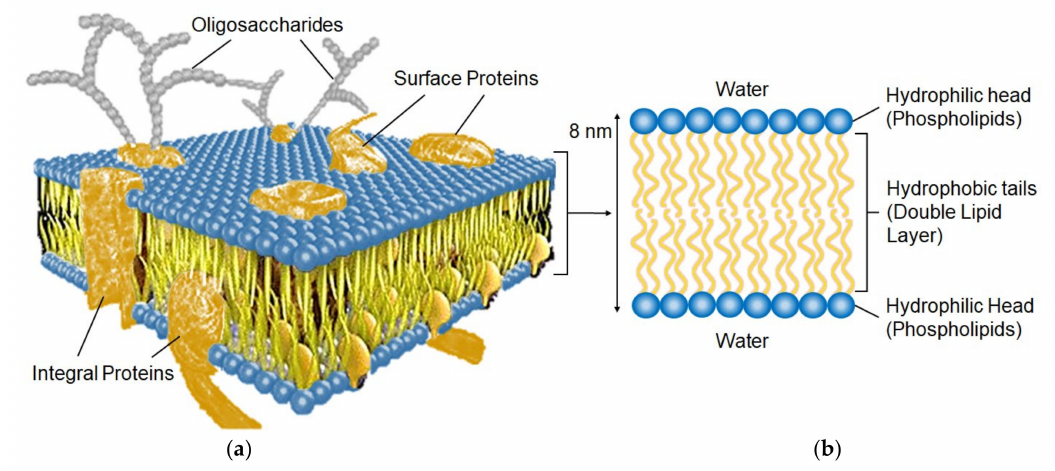
Figure 3. Schematic representation of a biological membrane ( a ) and lipid bilayer ( b ).